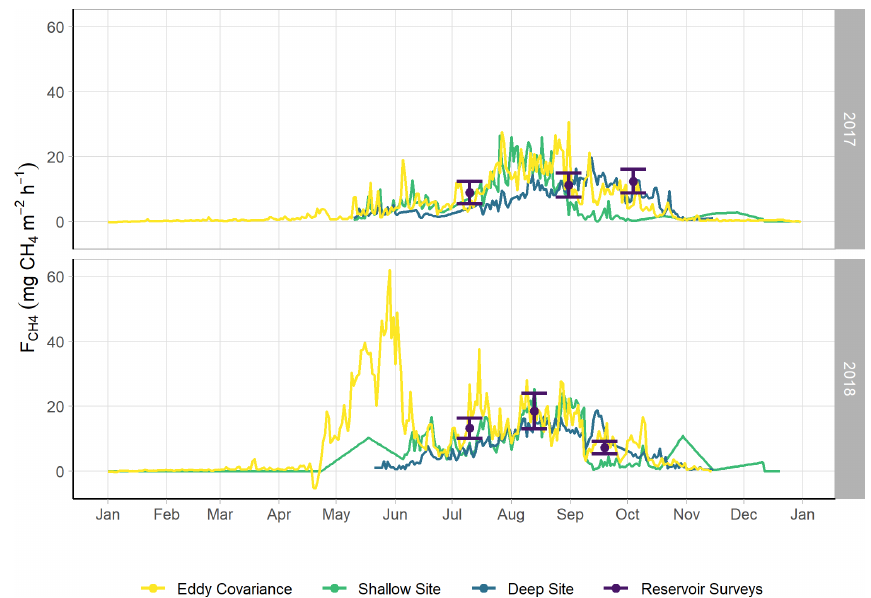
Figure 2. Time series of F CH monitored via multiple methods: eddy covariance (violet), the sum of the shallow AFT and interpolated 4 chamber measurements (blue, site U-14), the sum of the deep AFT and interpolated chamber measurements (green, site U-12), and via the spatially integrated lake-wide surveys (yellow). The error bars for the lake surveys indicate the 95% confidence interval of the mean. Error margins for the other measurements are omitted for figure legibility. The spring burst period was 24 May–4 June 2018. Table 1. Seasonal methane fluxes reported as mean fluxes and cumulative areal emissions from Acton Lake characterized by